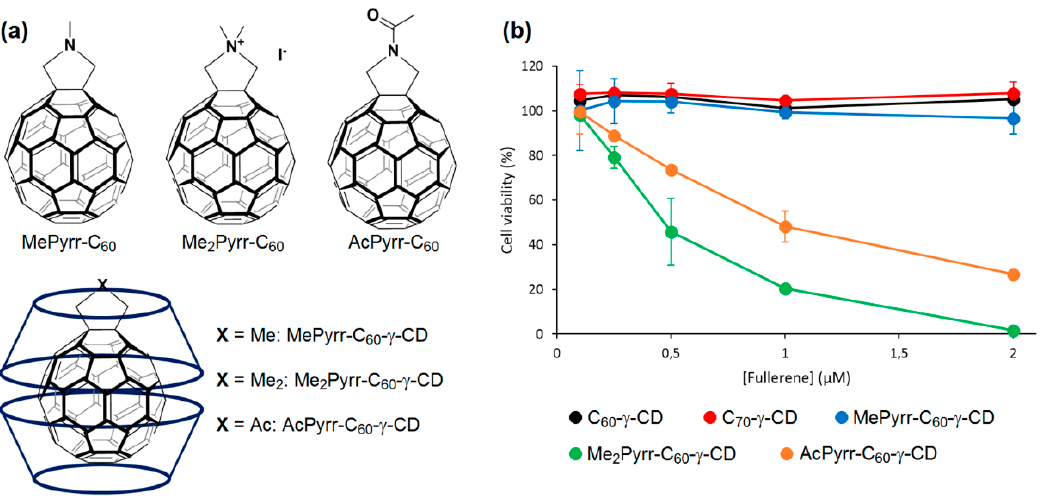
Figure 67. ( a ) Chemical structure of C 60 derivatives and C 60 derivatives- γ -CD inclusion complexes. ( b ) Concentration-dependent cytotoxicity of C 60 - γ -CD, C 70 - γ -CD, N -methylpyrrolidine (MePyrr)-C 60 - γ - CD, N , N -dimethylpyrrolidinium iodide (Me 2 Pyrr)-C 60 - γ -CD, and N- acetylpyrrolidine (AcPyrr)-C 60 - γ - CD on Hela cells under irradiation ( λ = 610–740 nm for 30 min). Adapted from Ikeda; Iizuka;